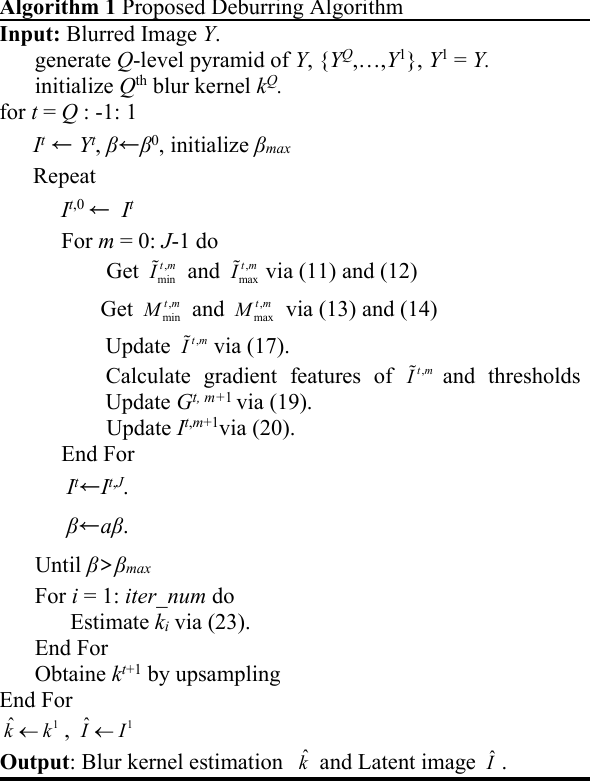
Algorithm 1 Proposed Deburring